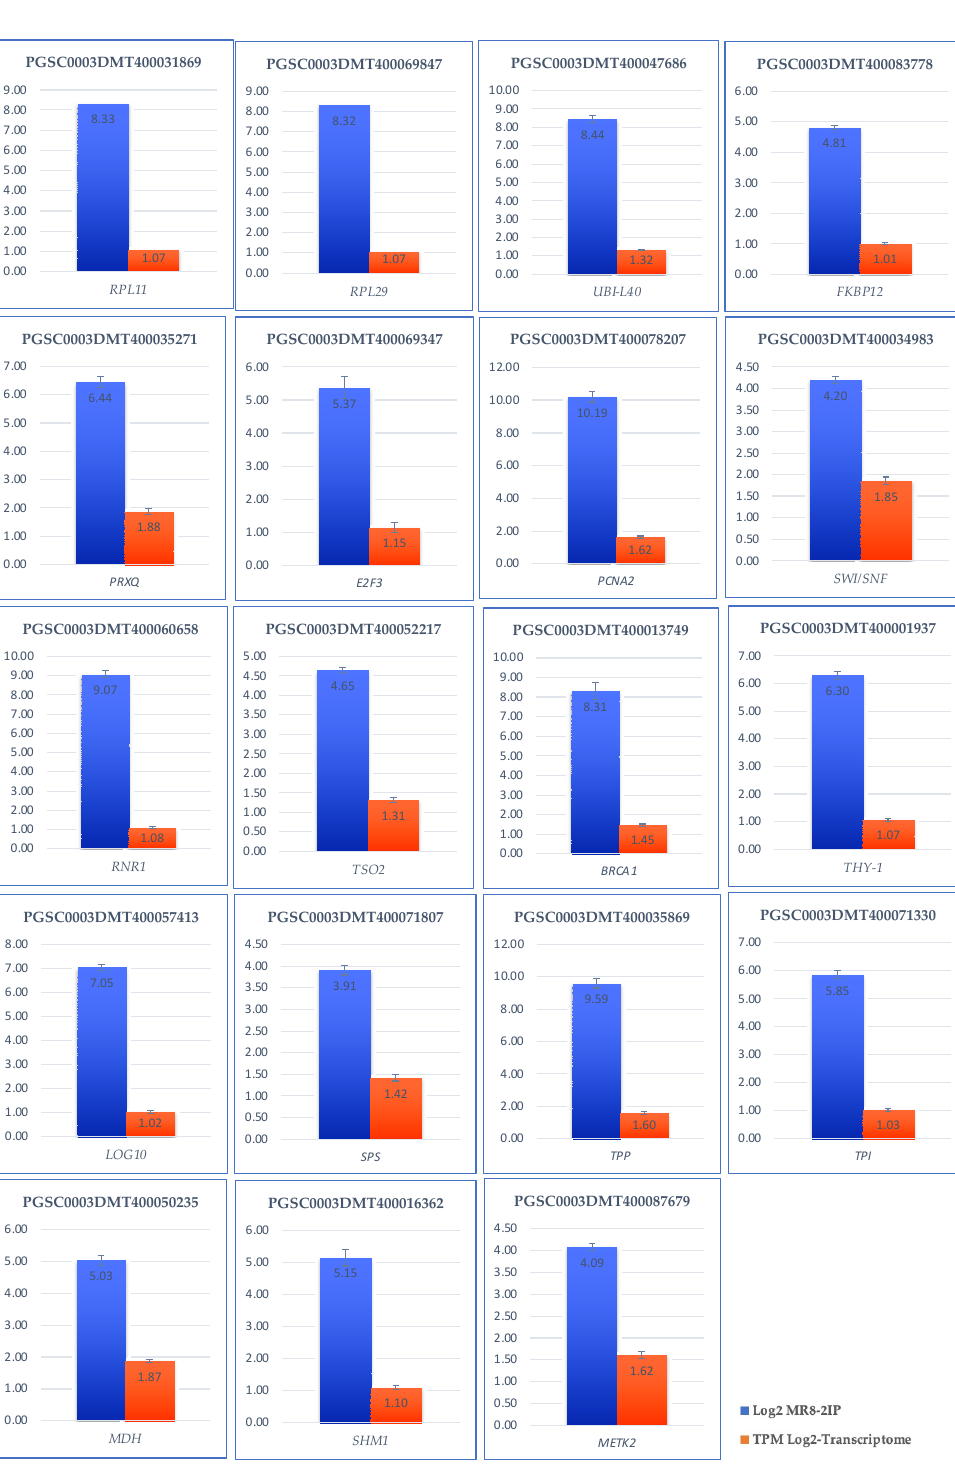
Figure 13. Validation of the transcriptomic-wide analysis by quantitative reverse transcription PCR (qRT-PCR) of 19 DEG up-regulated genes involved in RPs, PEBP, CC, carbon metabolism of potato S. tuberosum . Blue columns correspond to absolute gene expression derived from the genome-wide analysis. The orange bars represent the expression of the transcriptome expressing the number of transcripts per